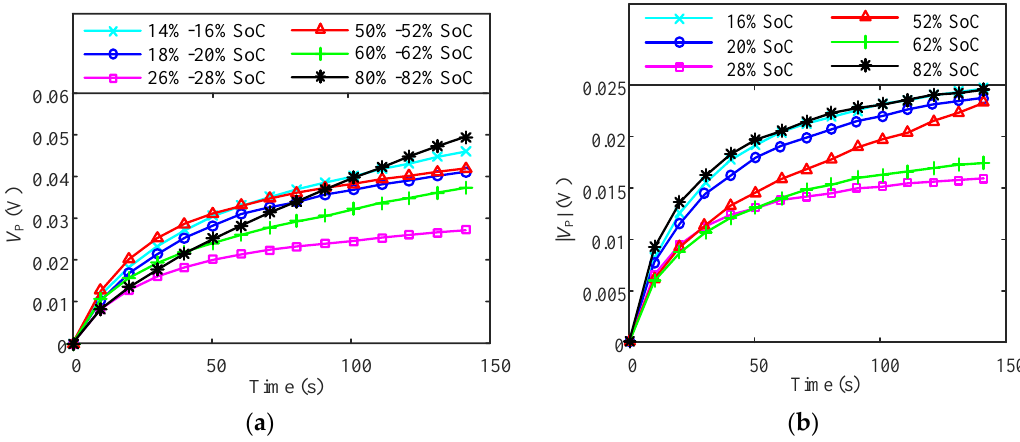
Figure 4. ( a ) The profiles of V P at different SoC intervals during the pulse-charging period; ( b ) the profiles of | V P | at different SoC points during the rest period.